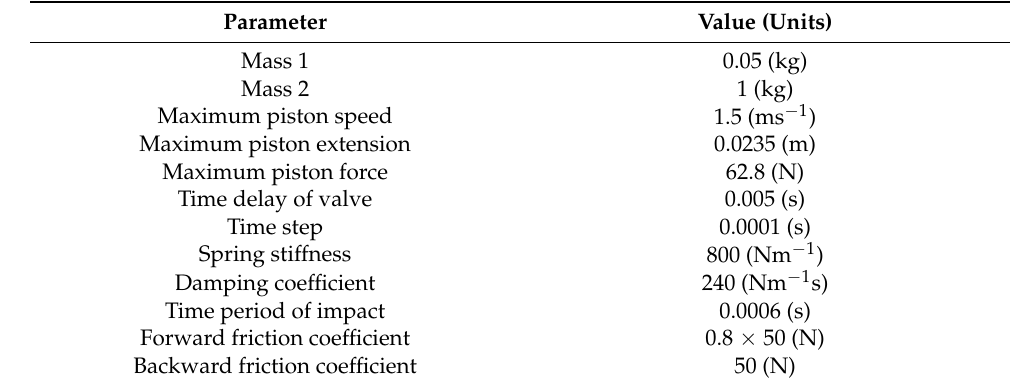
Table 1. Simulation